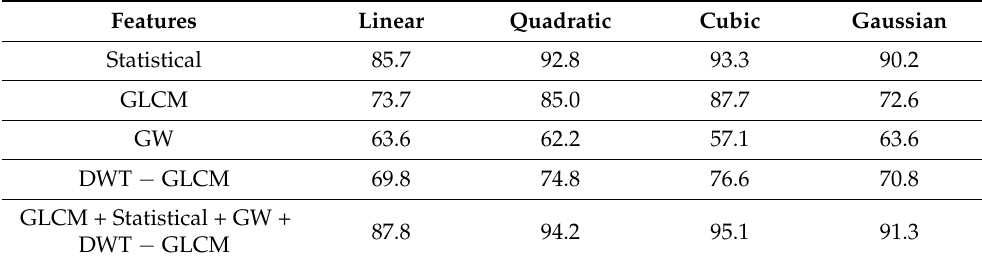
Table 1. The diagnostic accuracy (%) of the SVM classifiers trained with individuals and combined handcrafted features set from multiple